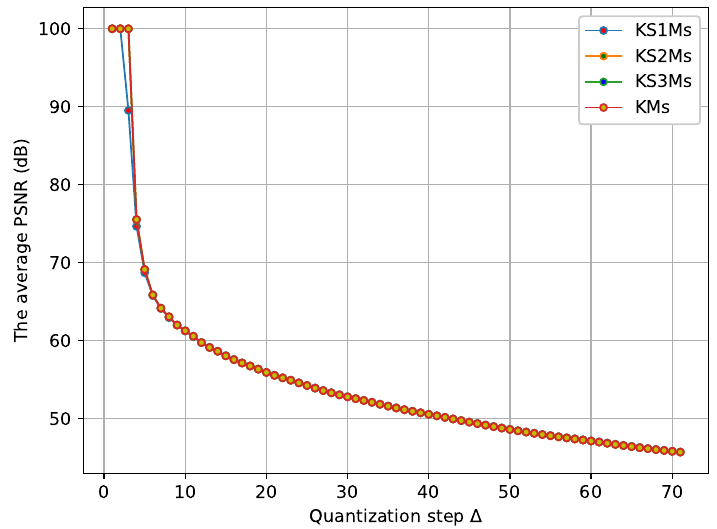
Figure 5. PSNR values of